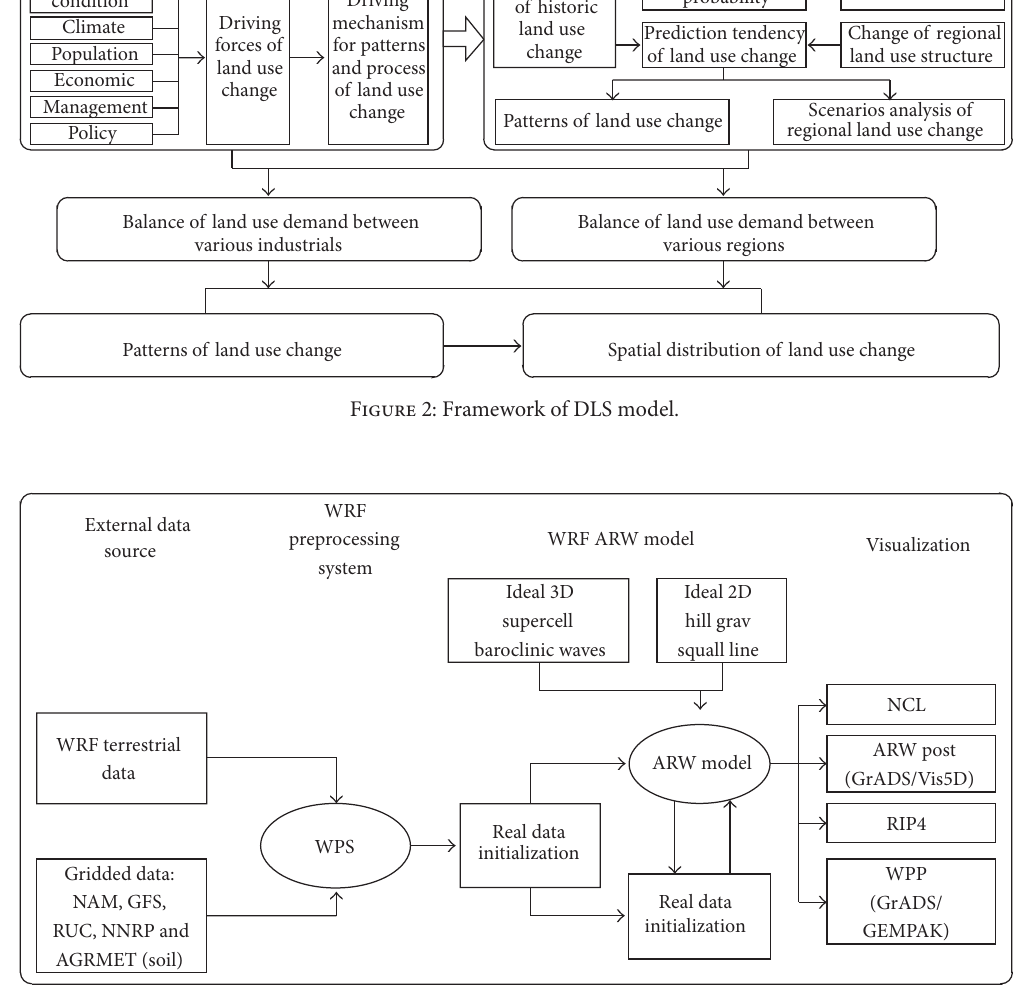
Figure 3: Framework of WRF